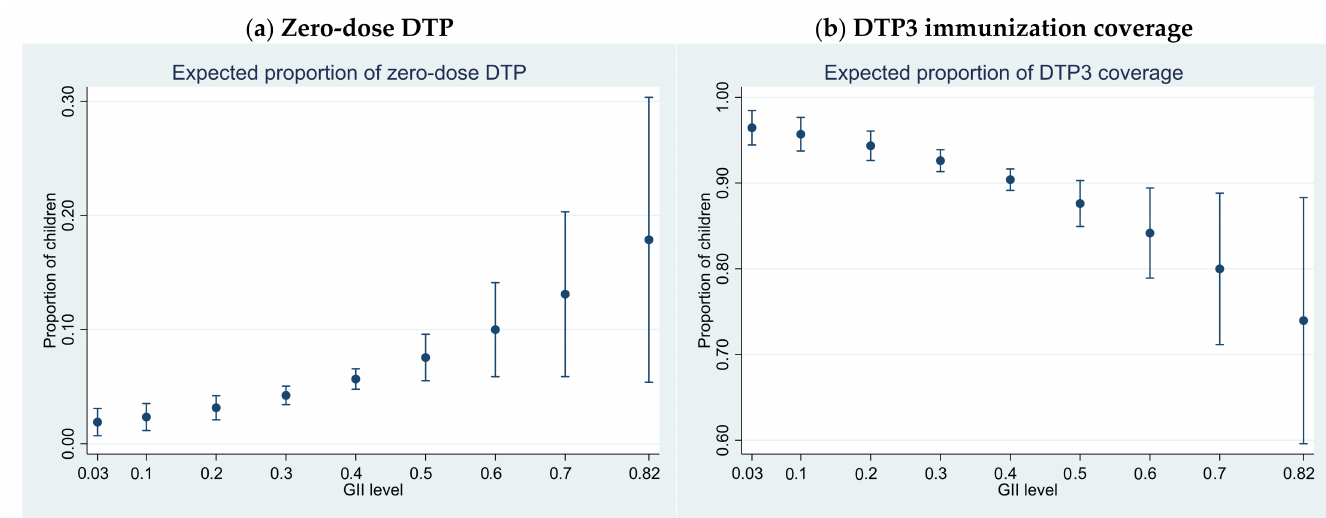
Figure 2. Average expected proportion of ( a ) zero-dose DTP and ( b ) DTP3 for fixed levels of GII, 161 countries (1 country did not have available data for this model), 2010–2019. Note: Results presented are from Model 2, controlling for annual population growth and age structure (measured as the percentage of the population under 15 years of age), percentage of urban population, and the three individual dimensional indices of the HDI (health index, education index, and GNI